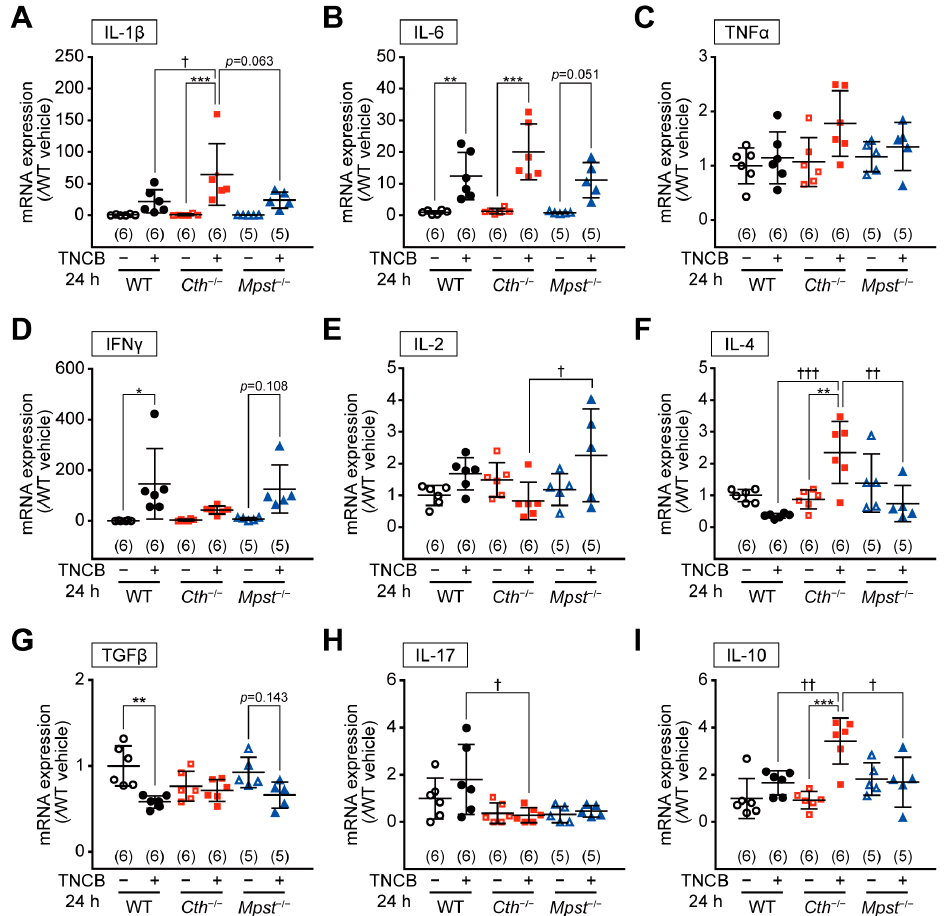
Figure 6. Expression levels of various cytokine mRNAs in the ear during trinitrochlorobenzene (TNCB)-induced contact dermatitis at 24 h after the challenge. IL-1 β ( A ), IL-6 ( B ), TNF α ( C ), IFN γ ( D ), IL-2 ( E ), IL-4 ( F ), TGF β ( G ), IL-17 ( H ), and IL-10 ( I ) mRNA levels were normalized by the house- keeping HPRT1 mRNA levels, and the relative expression versus vehicle-treated wild-type samples were calculated. Data are the mean ± SD with sample numbers in parentheses. Differences are significant by a one-way ANOVA with Tukey’s multiple comparison test at * p < 0.05, ** p < 0.01, and *** p < 0.001 versus vehicle-treated samples of each genotype; † p < 0.05, †† p < 0.01, and ††† p < 0.001 between genotypes.